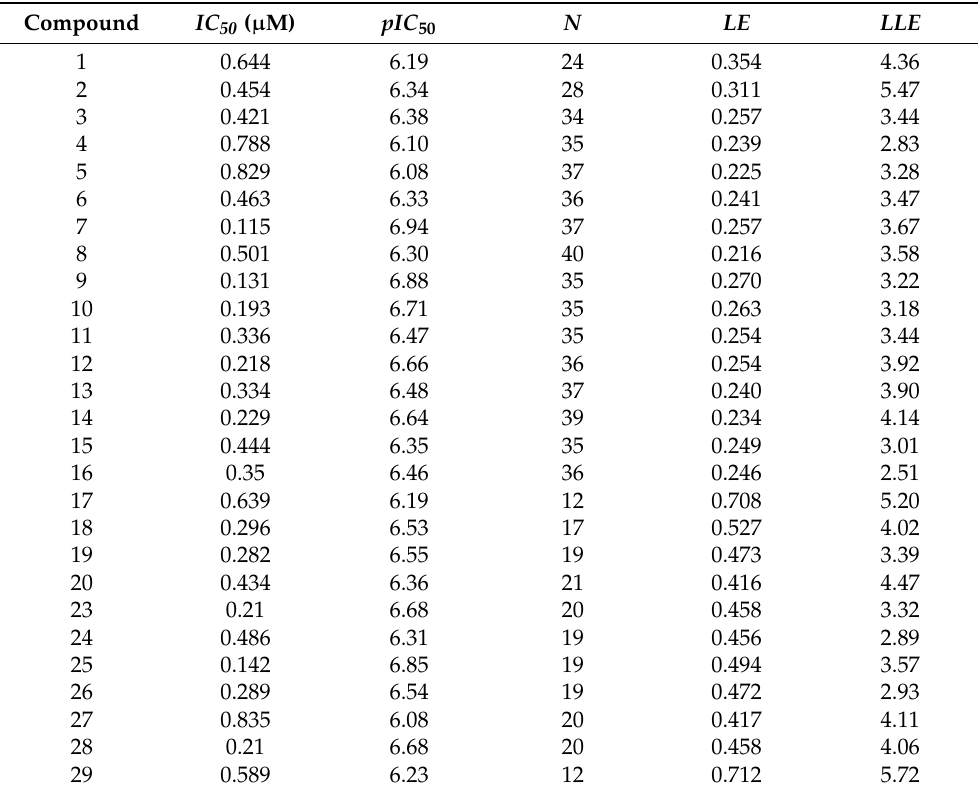
Table 4. LE and LLE values of compounds 1–20 and 23-29